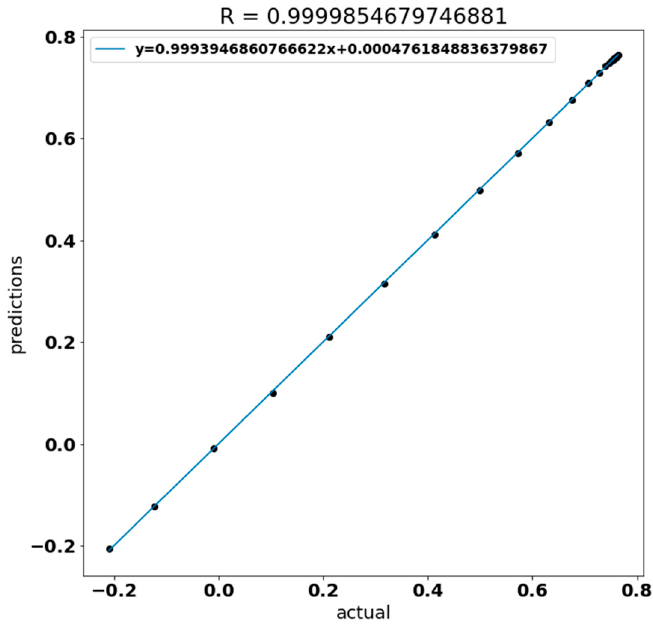
Figure 16. Correlation between the predicted current and the actual measurements.